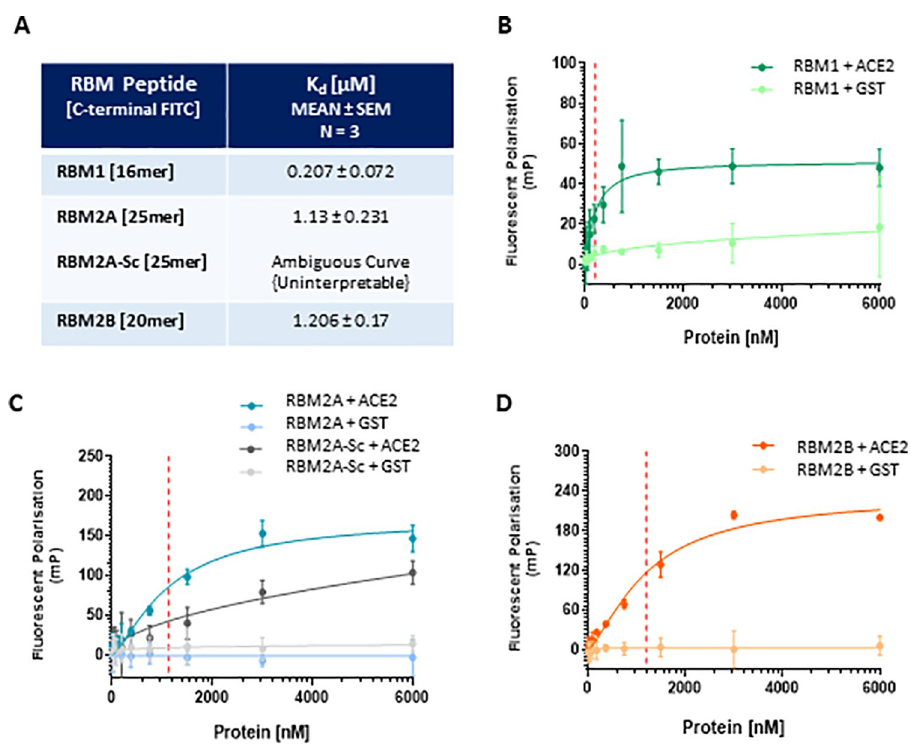
Fig 4. Direct binding assay for ACE2 and RBM-derived peptides (FP; fluorescent polarisation). Increasing concentrations of ACE2-Fc or GST purified recombinant protein (0.012 nM– 6 μ M) were incubated with 500 nM of RBM peptide (FITC labelled) at room temperature, FP measured at 2 hours and binding affinities calculated via non- linear regression analysis (A). Binding saturation curves of (B) RBM1, (C) RBM2A and RBM2A-Sc, (D) RBM2B binding. GST represents negative protein control. Binding affinity (Kd, red vertical line) measurements represented as MEAN ± SEM, N = 3 independent experiments.